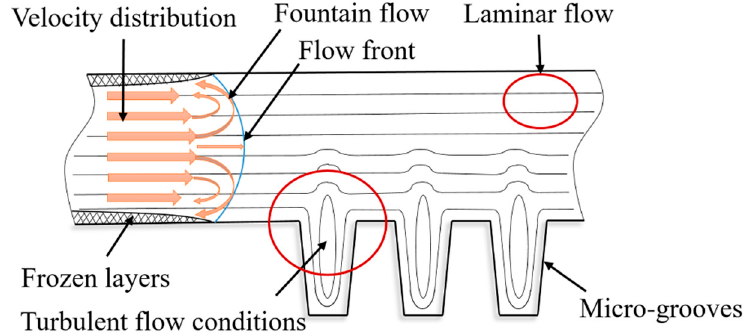
Figure 1. Flow of viscous fluid in cavity with micro-grooves.